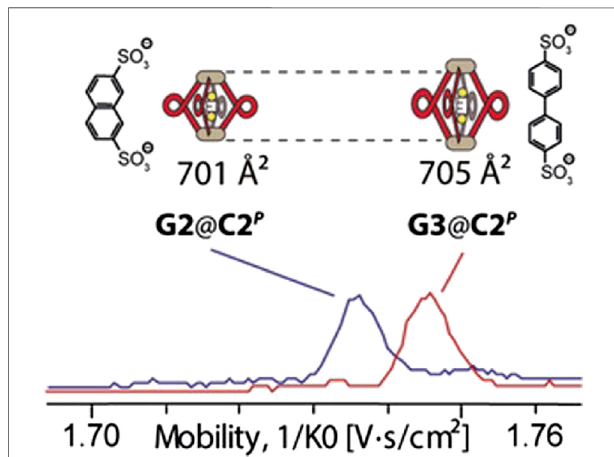
FIGURE 13 | The difference in ion mobility measured by TIMS-TOF of two host-guest complexes can be linked to the change in helical pitch of a constituent ligand as the length of the guest is varied (Schulte et al.,